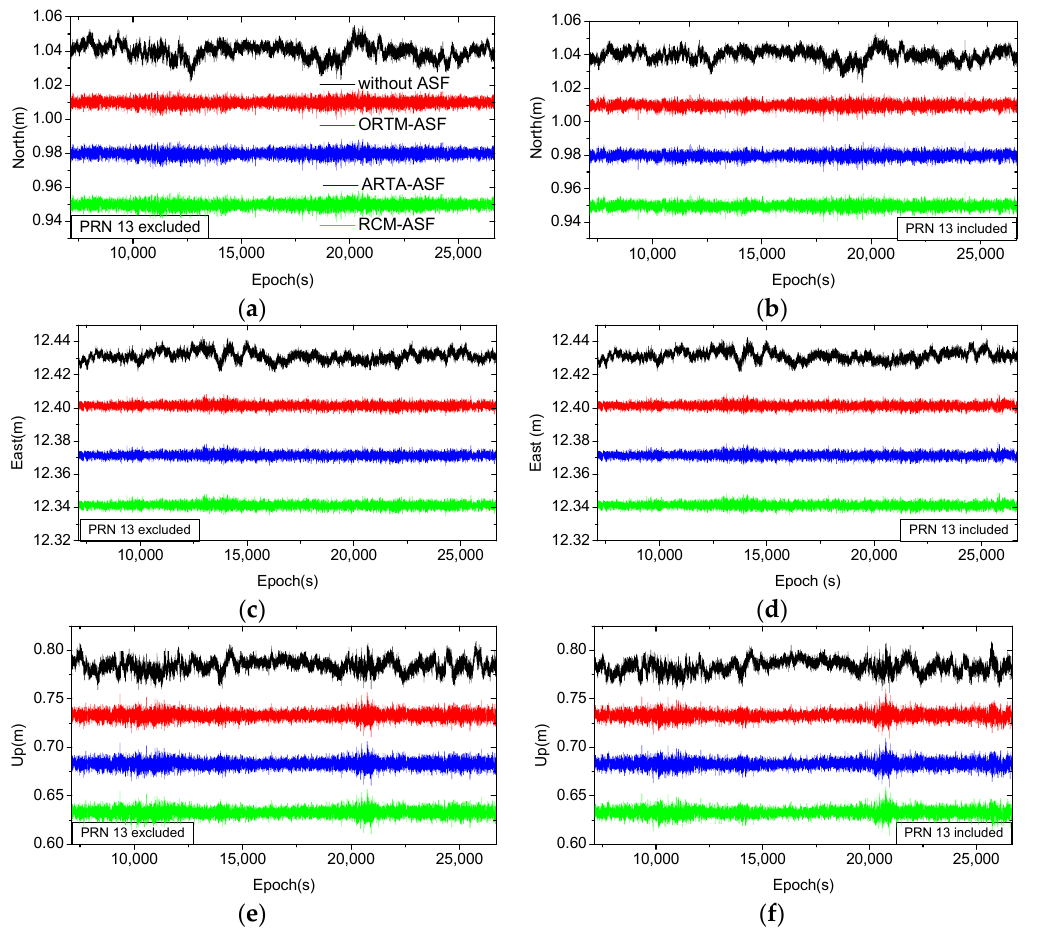
Figure 8. Baseline components estimated from the observables with ORTM-ASF correction, with ARTA-ASF correction, with RCM-ASF correction, and without any ASF correction for DOY 344, 2014. ( a , c , e ) are N, E, and U components estimated with satellite of PRN 13 excluded. ( b , d , f ) are N, E, and U components estimated with satellite of PRN 13 included. For comparison, time series of “ORTM-ASF”, “ARTA-ASF”, and “RCM-ASF” are shifted by − 3, − 6, and − 9 cm for N and E, and by − 5, − 10, and − 15 cm for U. Legend shown on ( a ) is for all of ( a – f ). The time series are shown from epoch 7130 to epoch 26,681, when the data of satellite PRN 13 were